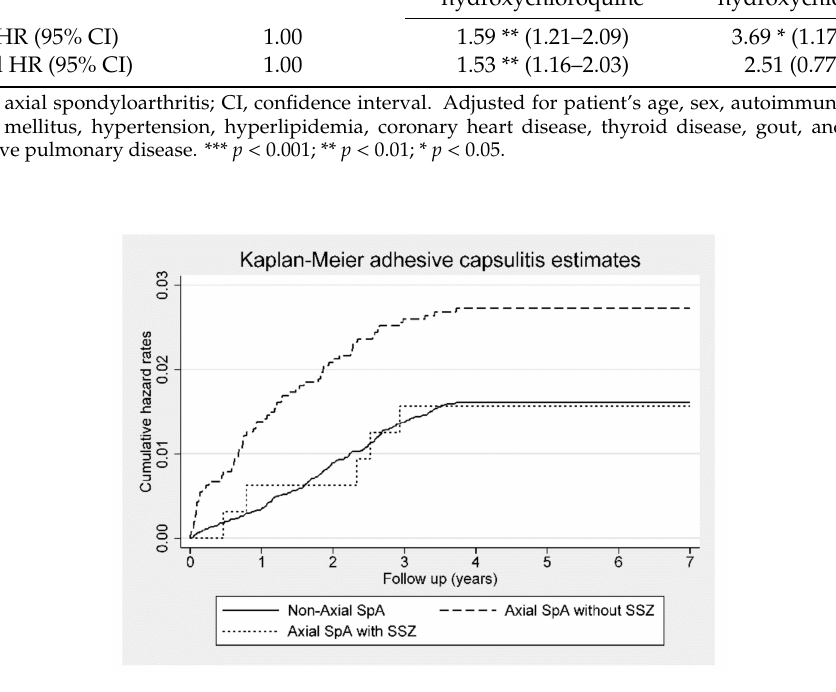
Figure 3. Kaplan–Meier hazard curve for adhesive capsulitis in patients with axial spondyloarthritis